Question: From the figure, is the trend upward or downward?
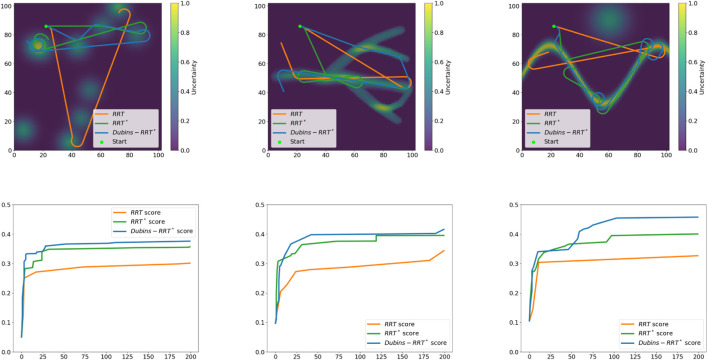
Answer: increasing